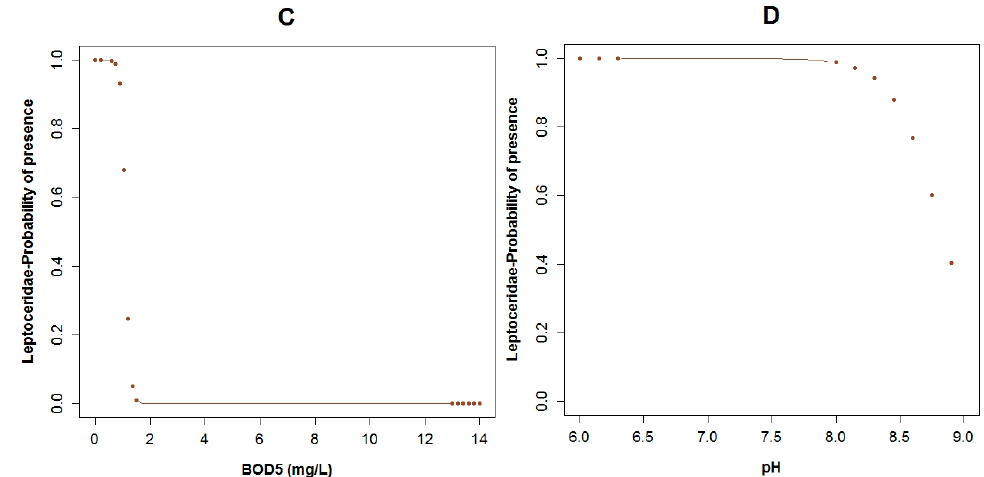
Figure A10. The probability of Leptoceridae being present in relation to ( A ) log fecal coliforms; ( B ) COD; ( C ) BOD 5 ; ( D ) pH. (The brown points in the curves indicate extrapolation outside the observed physicochemical variables) range.